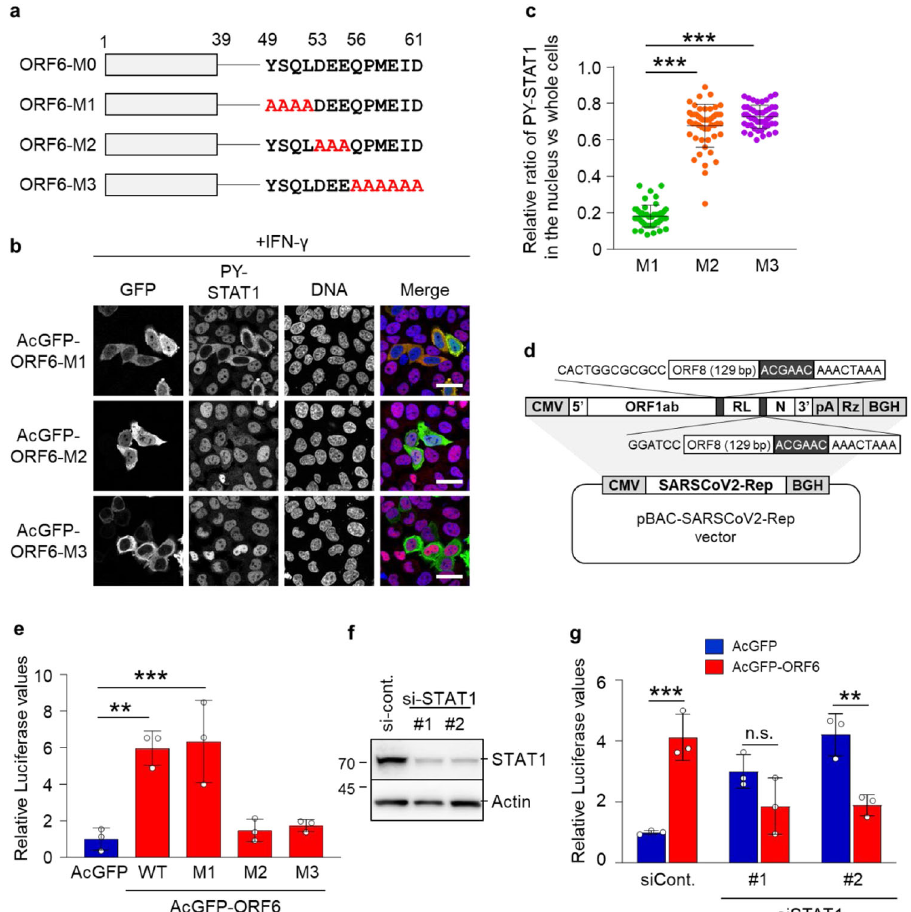
Fig. 2 The C-terminal region of ORF6 participates in viral RNA replication. a Schematic representation of ORF6 and its alanine substitution mutations within the C-terminus. ORF6-M0: ORF6 wild type; ORF6-M1: ORF6 with amino acids 49-52 substituted for alanine; ORF6-M2: ORF6 with amino acids 53- 55 substituted for alanine; ORF6-M3: ORF6 with amino acids 56 – 61 substituted for alanine. b Immuno fl uorescence of PY-STAT1 in HeLa cells transfected with the AcGFP-ORF6 mutants following IFN- γ stimulation. GFP (green) and PY-STAT1 (red) were identi fi ed using speci fi c antibodies. DAPI was used to stain the DNA (blue). Scale bars: 30 μ m. c The graph represents the relative fl uorescence values of PY-STAT1 in the nucleus compared to those of the whole cells in b . Signal intensities of total 50 nuclei from two independent experiments were measured. *** P < 0.001, one-way ANOVA. error bars represent SD. d Schematic representation of SARS-CoV-2 replicon DNA, pBAC-SCoV2-Rep. The genetic structure of the SARS-CoV-2 replicon is shown at the top of the panel. The dark shaded box indicates the core sequence of transcription regulating sequence. CMV cytomegalovirus promoter, RL Renilla luciferase gene, pA a synthetic poly(A) tail, Rz hepatitis delta virus ribozyme, BGH bovine growth hormone polyadenylation sequence. e Relative luciferase values for ORF6 wild type (WT) or each mutant in replicon ( n = 3). ** P < 0.01, *** P < 0.001, one-way ANOVA. error bars represent SD. f Huh7 cells were transfected with siRNAs for STAT1 (si-STAT1) or control siRNA (si-cont.), and cell lysates were subjected to western blotting. Two different siRNAs (shown as #1 and #2) for STAT1 were used for this knockdown experiment. The proteins were detected using speci fi c antibodies for STAT1 or Actin. Values are kDa. g Huh7 cells were transfected with the indicated siRNAs overnight and then transfected with pBAC-SCoV2-Rep together with AcGFP or AcGFP-ORF6 for 24 h. Relative luciferase values were determined by luciferase assay ( n = 3). ** P < 0.01, *** P < 0.001, n.s.: not signi fi cant, two-way ANOVA. error bars represent